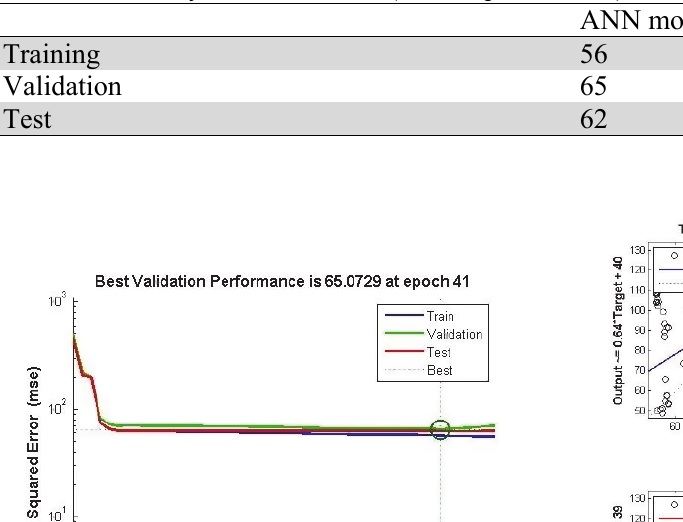
Performance analysis of ST model (mean squared error)